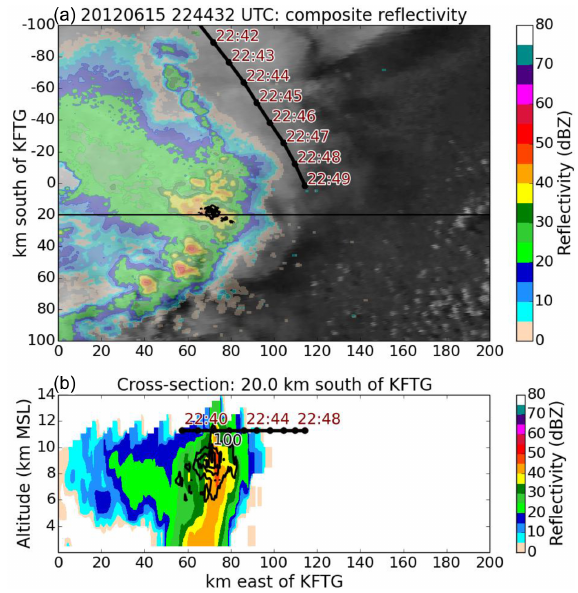
Figure 5. Two-panel plot of (a) composite reflectivity (dBZ; col- ored contours) in plan view superimposed on GOES-West visible satellite imagery and (b) west–east radar reflectivity cross-section through the 15 June 2012 case at 22:44. Radar reflectivity is from the KFTG (Denver, CO) NEXRAD radar. The G-V flight track from 22:40 to 22:49 is indicated by the thick black line; the G-V posi- tion at every minute is indicated by the black dots along the line, and UTC times along the track are labeled in brown. The position of the cross-section in (b) is indicated by the thin black horizontal line in (a) . The black contours superimposed on the radar reflec- tivity are (a) contours of vertically integrated LMA VHF source densities (b) LMA source densities horizontally integrated in the north-south direction. Contours indicate regions of frequent light- ning discharges (large numbers of LMA-detected